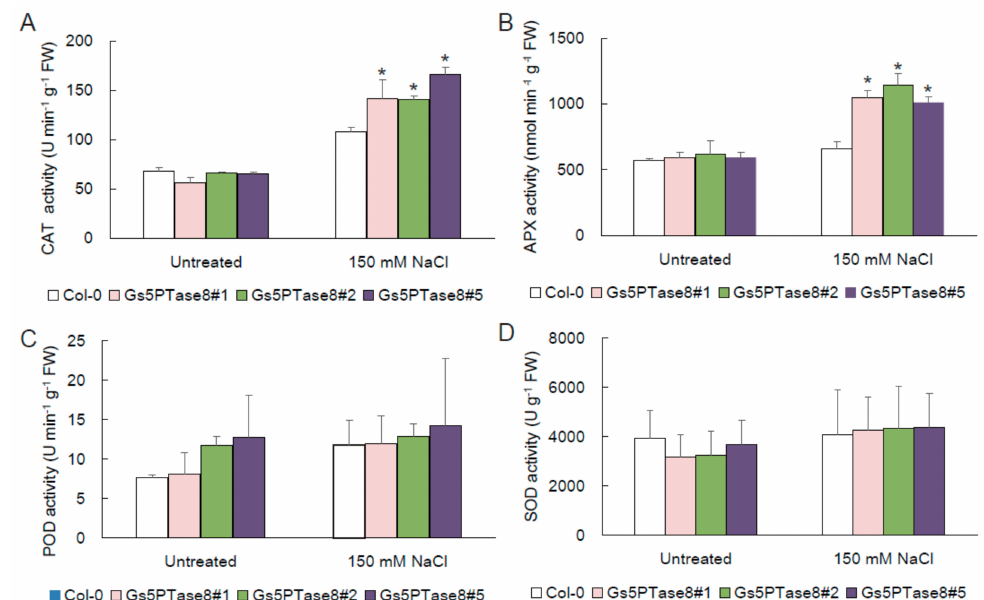
Figure 5. Activities of antioxidant enzymes in Gs5PTase8 -transgenic Arabidopsis under salt treatment. The ten-day-old Arabidopsis seedlings were treated with or without 150 mM NaCl for 24 h. ( A ) CAT activity, ( B ) APX activity, ( C ) POD activity, and ( D ) SOD activity. The data were analyzed using ANOVA by the Dunnett’s post hoc test. Asterisk indicates a significant di ff erence between the wild type and the transgenic lines ( p <